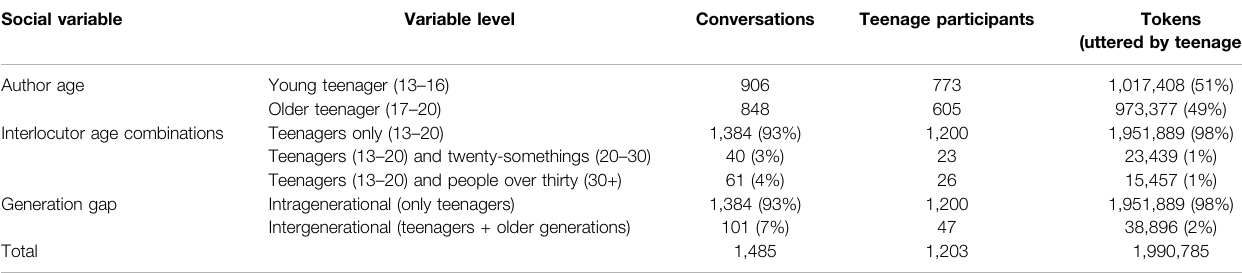
TABLE 1 | Distributions in the corpus with respect to interlocutors ’ age 4